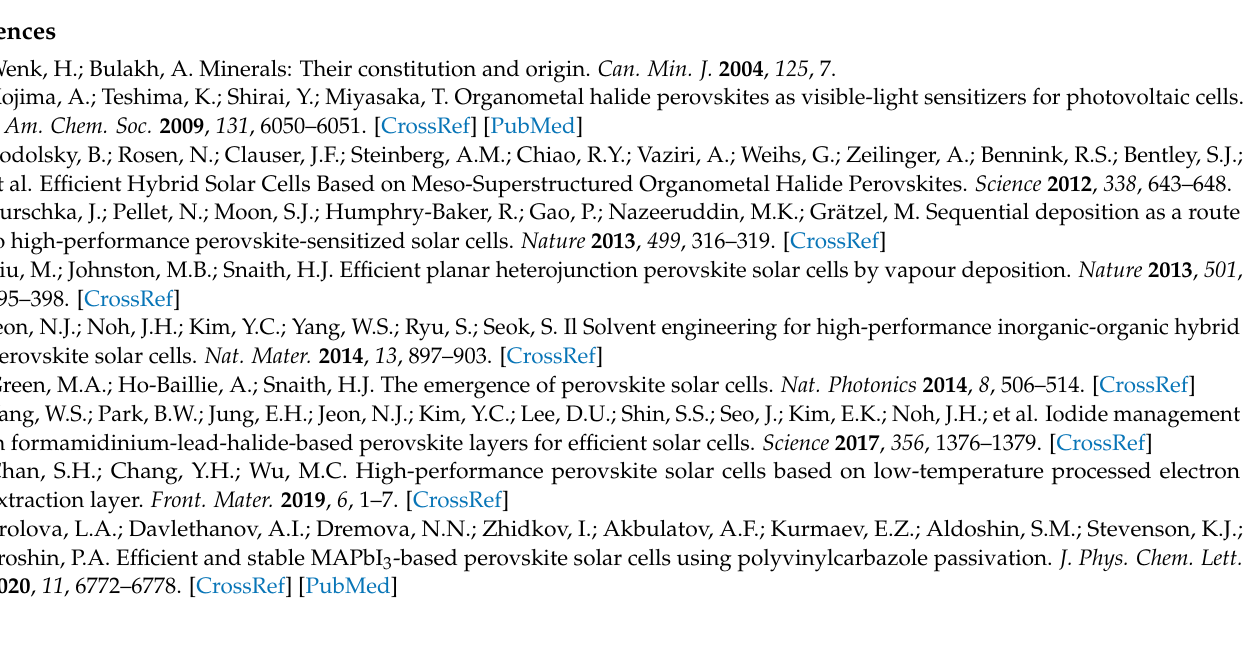
layers with a total thickness and the average stoichiometry of 3.61 × 10 17 atoms/cm 2 and Pb 0.35 I 0.65 and 4.22 & Pb 0.24 Sn 0.11 I 0.30 Cl 0.36 , respectively. While the spectra in Figure S2c–e were simulated using three layers with a total thickness ( × 10 17 atoms/cm 2 ) and average stoichiometry of, 4.59 & Pb 0.23 Sn 0.21 I 0.11 Cl 0.43 , 4.94 & Pb 0.23 Sn 0.27 I 0.04 Cl 0.45 and 6.01 & Pb 0.19 Sn 0.30 I 0.02 Cl 0.48 , respectively, Figure S3: Tauc Plots for the bandgap measurement from the UV-Vis spectra of (a) PbI 2 film, (b) SnCl 2 film and (c–f) mixed SnCl 2 -PbI 2 compound films. The bang gaps of PbI 2 and SnCl 2 films were found to be 2.42 eV and 3.92 eV, respectively. While the band gaps of mixed SnCl 2 -PbI 2 compound films i.e., (2.5:20) mg, (5:20) mg, (10:20) mg and (15:20) mg were found to be 2.79 eV, 2.93 eV, 3.10 eV and 3.31 eV, respectively, Figure S4: Crystallite size evolution upon increasing the concentration of Sn, (a) includes MAPbI 3 and all the mixed metal perovskite. (b) Excludes the 45.8 nm average crystallite size for MAPb 0.69 Sn 0.31 I 3 perovskite and includes the trendline to guide the eye, Figure S5: Tauc Plots for the bandgap measurement from the UV-Vis spectra of (a) MAPbI 3 film, (b–e) mixed metal perovskite films and (f) MASnI 3 film. The bang gaps of MAPbI 3 and MASnI 3 films were found to be 1.59 eV and 1.15 eV, respectively. While the band gaps of mixed metal perovskite films i.e., MAPb 0.69 Sn 0.31 I 3 , MAPb 0.52 Sn 0.48 I 3 , MAPb 0.46 Sn 0.54 I 3 and MAPb 0.39 Sn 0.61 I 3 were found to be 1.58 eV, 1.44 eV, 1.41 eV and 1.26 eV, respectively, Figure S6: Urbach energy approximation plots of (a) MAPbI 3 film, (b–e) mixed metals perovskite films and (f) MASnI 3 film. The Urbach energies of MAPbI 3 and MASnI 3 films were found to be 0.07 eV and 0.53 eV, respectively. While the Urbach energies of mixed metal perovskite films i.e., MAPb 0.69 Sn 0.31 I 3 , MAPb 0.52 Sn 0.48 I 3 , MAPb 0.46 Sn 0.54 I 3 and MAPb 0.39 Sn 0.61 I 3 were found to be 0.06 eV, 0.22 eV, 0.26 eV and 0.28 eV,